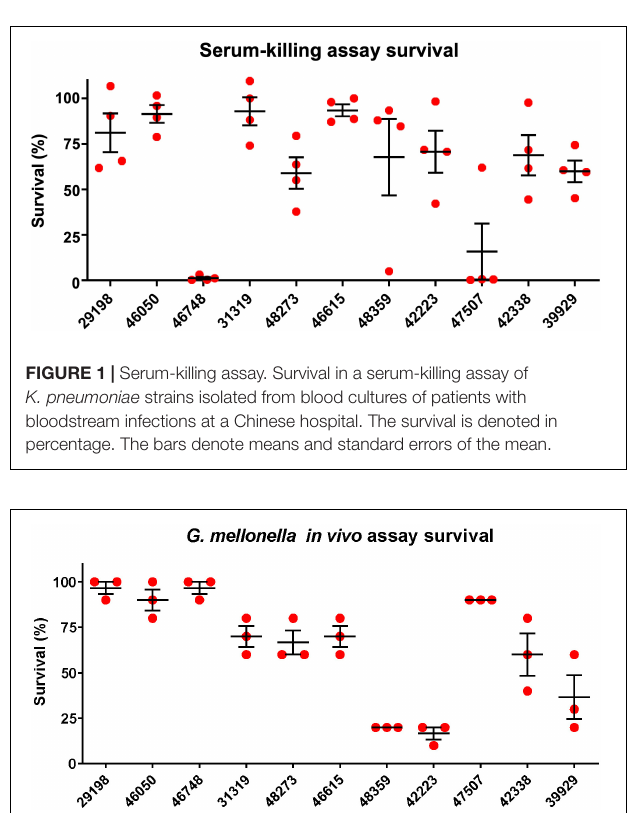
FIGURE 2 | Galleria mellonella infection assay. Survival at 24 h in a Galleria mellonella assay of K. pneumoniae strains isolated from blood cultures of patients with bloodstream infections at a Chinese hospital. The survival is denoted in percentage. The bars denote means and standard errors of the